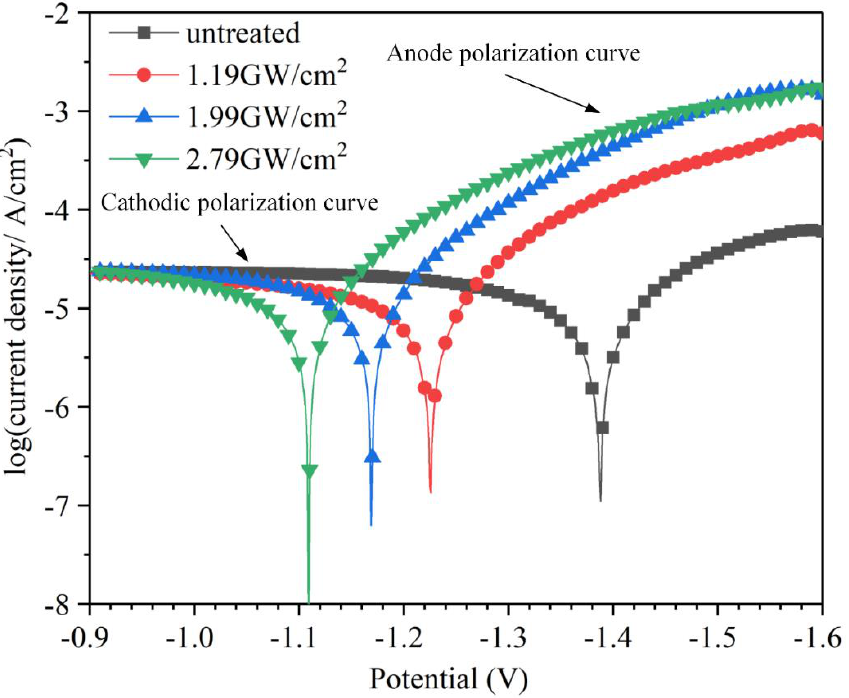
Figure 14. Potentiodynamic polarization curves of the untreated, 1.19 GW / cm 2 , 1.99 GW / cm 2 , and 2.79 GW / cm 2 in SBF solution. Table 4. The electrochemical parameters of potentiodynamic polarization curves.